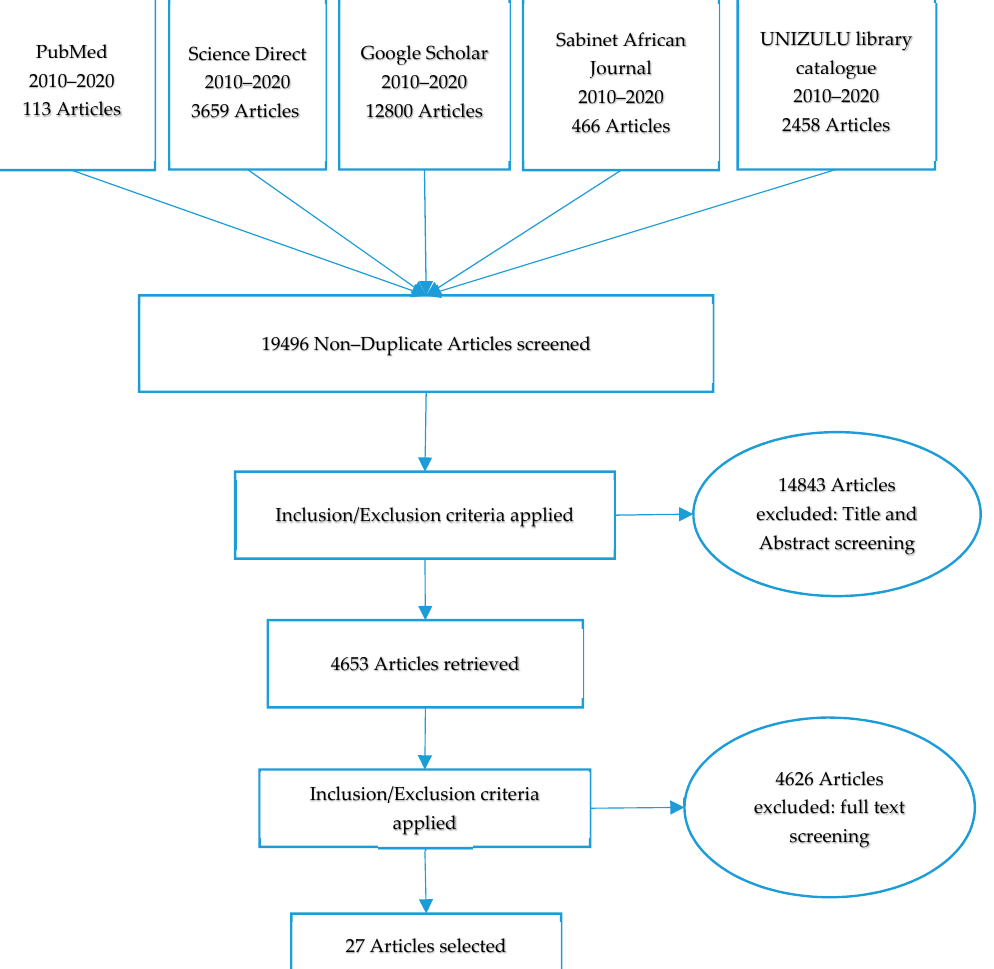
Figure 2. Flow chart of search strategy result.